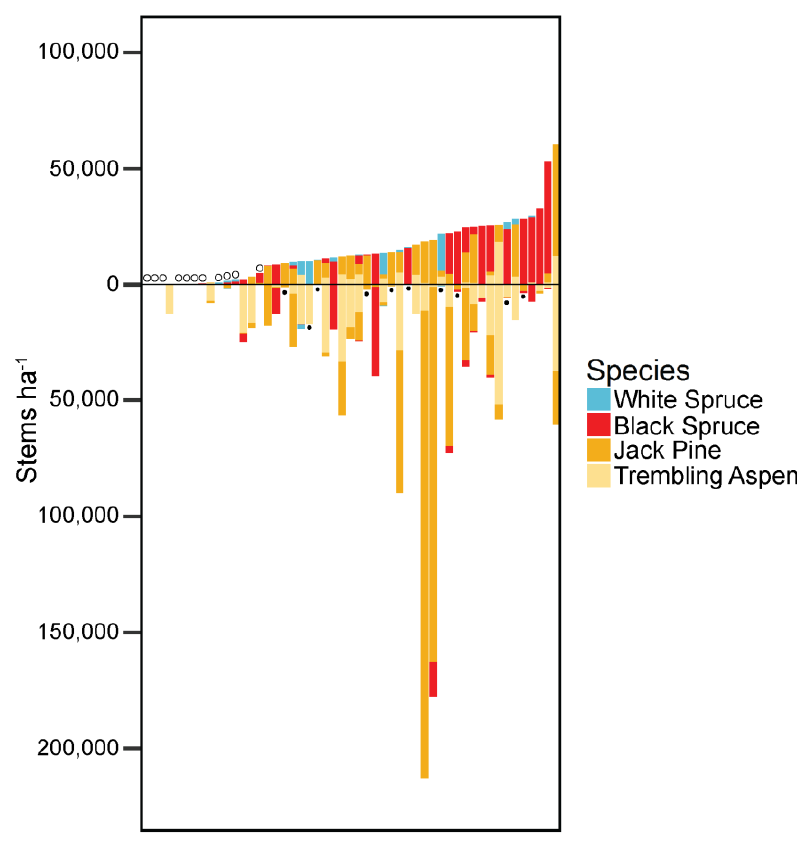
Figure A3. Pre-fire overstory (top) and post-fire (bottom) densities of trees (stems per ha −1 ) by species at 51 sampled field sites. Sites are ordered from left to right by increasing pre-fire stem density. Non-forested open wetland sites are indicated with a letter O above the pre-fire stem density. Open wetlands and all sites indicated with a black dot below the post-fire density were sampled one year post-fire only. All other sites represent seedling data from three years post-fire. Forests 2018 , 9 , x FOR PEER REVIEW